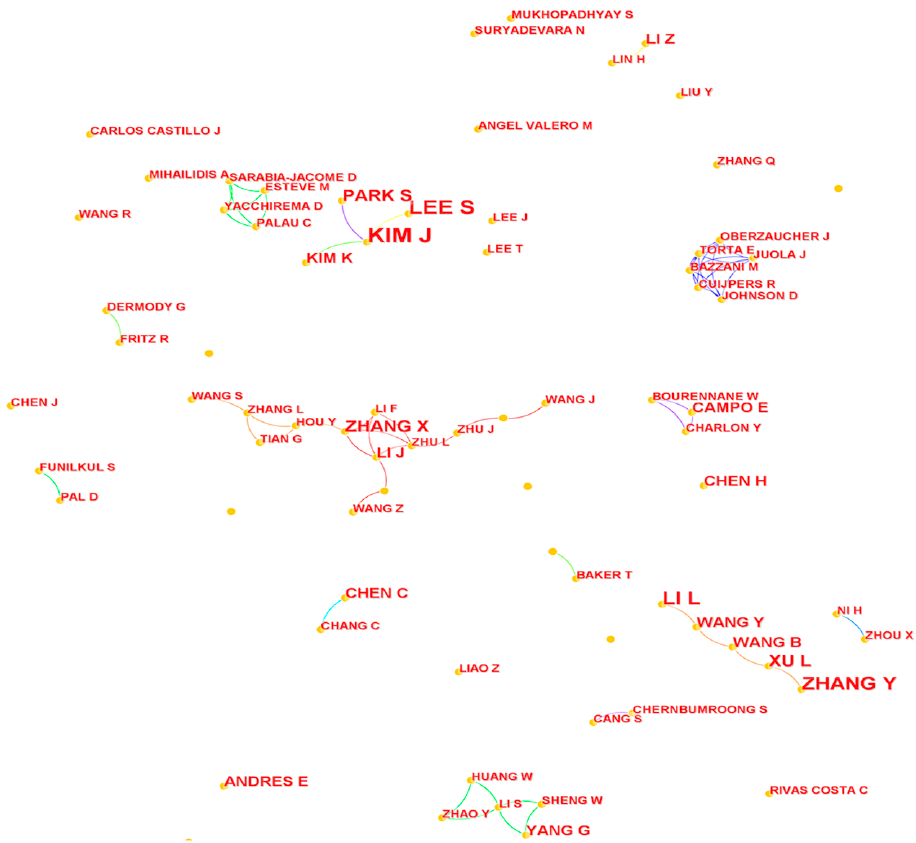
Figure 4. The author network of studies from WOS.